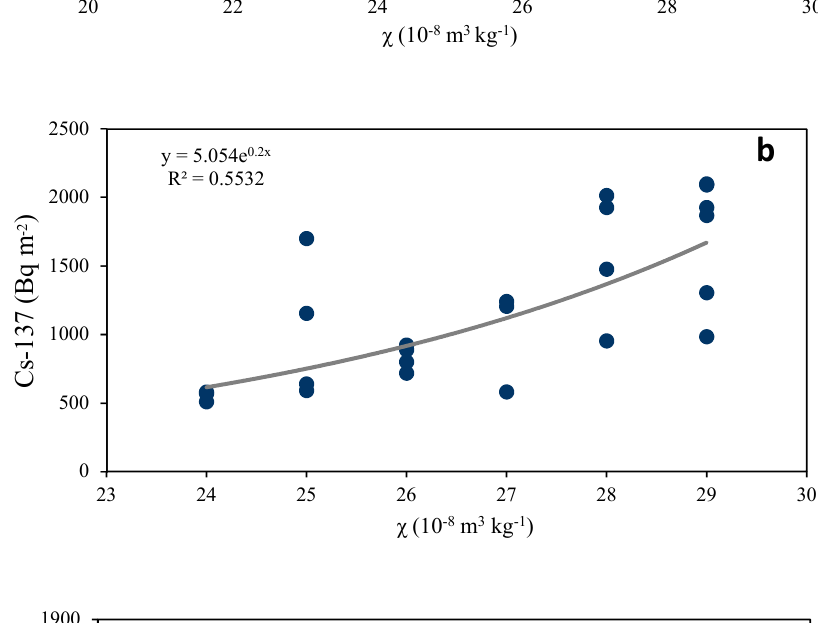
Figure 6. As can be seen, non-linear correlations between 137 Cs and magnetic susceptibility were significantly higher than linear correlations. Similarly, in the Fereydunshahr district, Rahimi et al. [21] showed that non-linear relationships could explain 74% and 76% of the variability in 137 Cs in the pasture and cultivated soils, respectively. In Chelgerd district, Charmahal and Bakhtiari province, west of Iran, Ayoubi et al. [47] found R 2 = 0.45 for the non-linear relationships between 137 Cs and magnetic susceptibility.